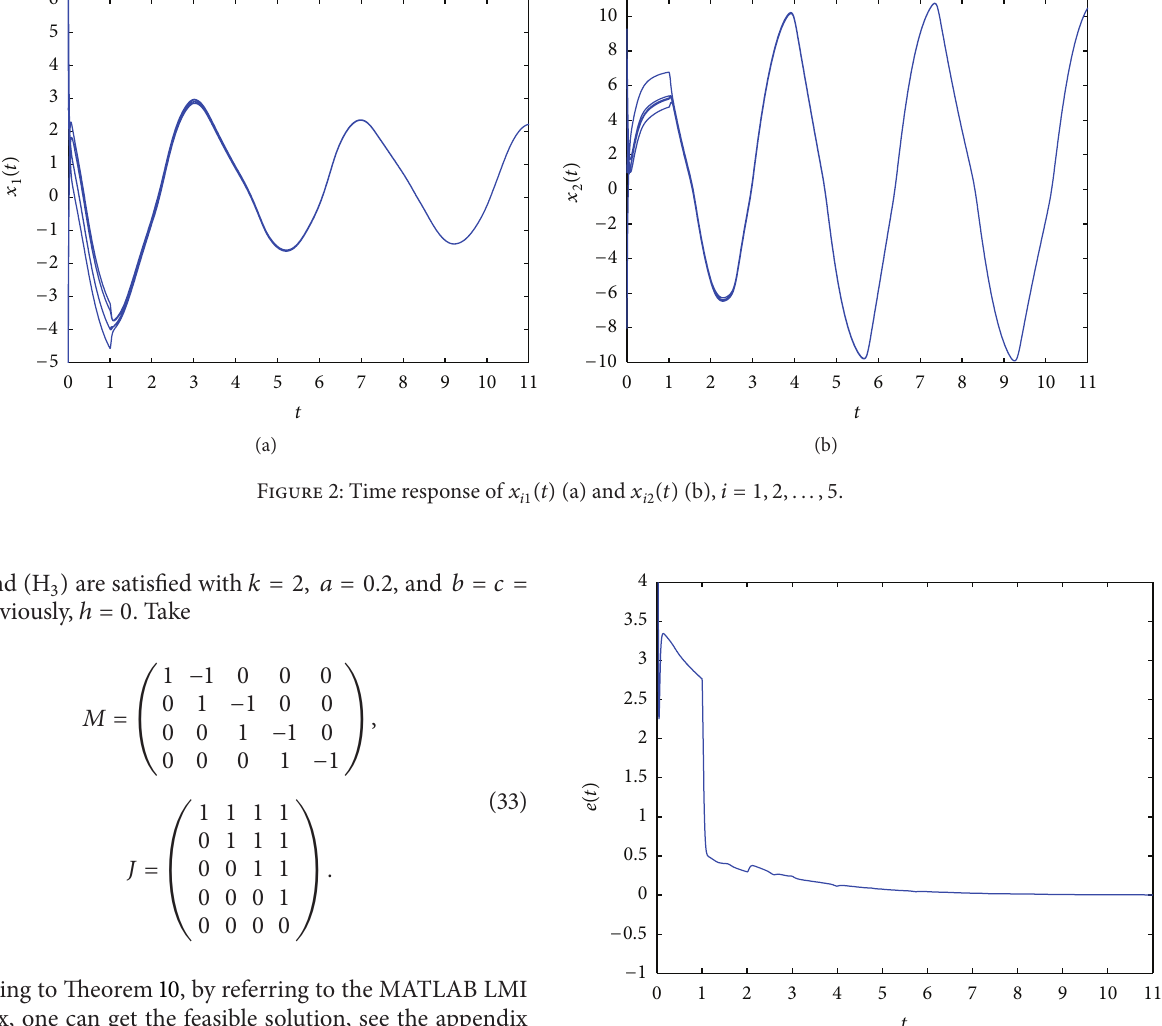
Figure 3: Error distance of the coupled network (30).